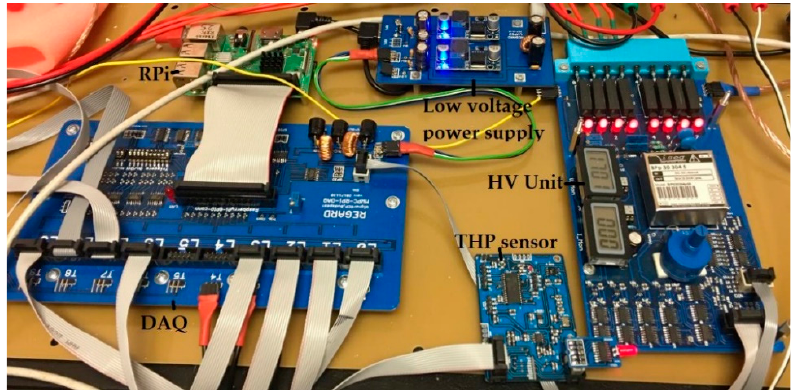
Figure 4. Data Acquisition system for a muon telescope setup.